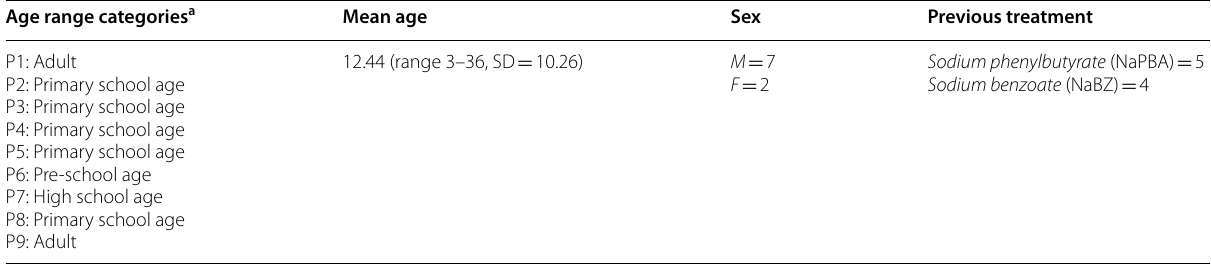
Table 2 Demographic data of child with UCD (all interviews undertaken with carers)